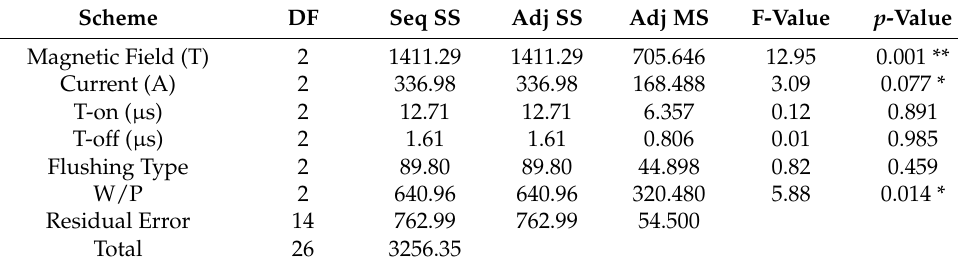
Table 4. ANalysis of VAriance (ANOVA) for Material Removal Rate